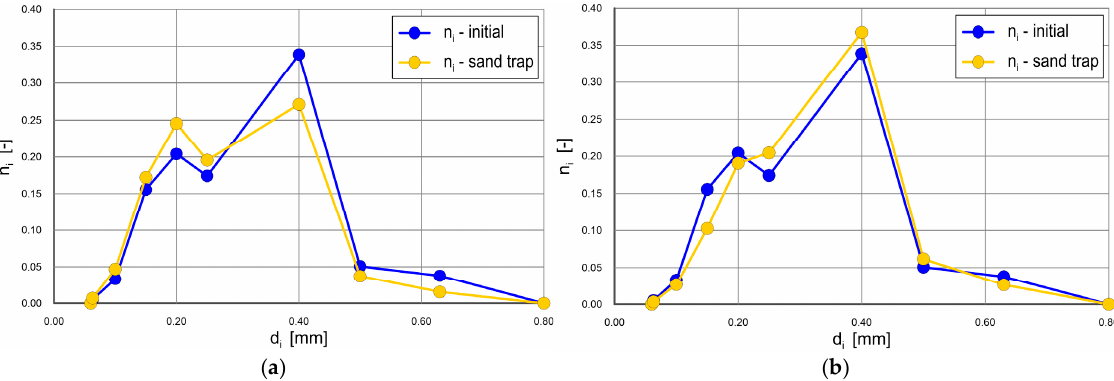
Figure 4. Grain size distribution of quartz sand in the trap at the flow ( a ) 8 L/s and ( b ) 14 L/s in the Gda ń sk 2021 experiment.